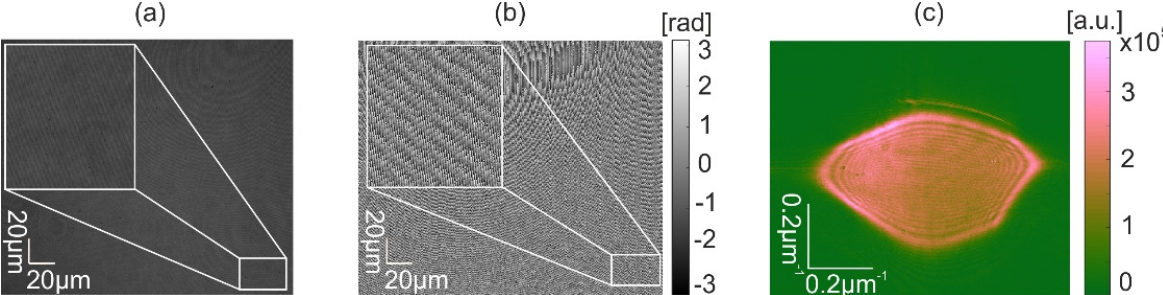
Figure 8. Example of experimental data: ( a ) recorded hologram, ( b ) phase, and ( c ) Fourier spectrum of the object in linear scale.